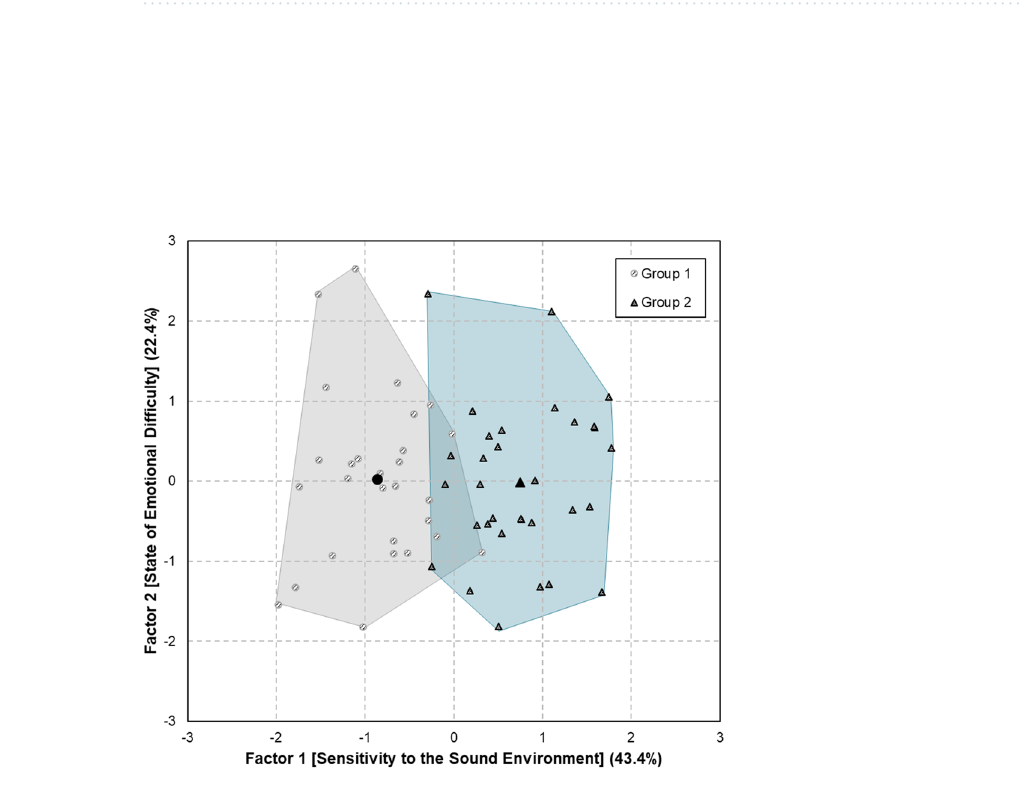
Table 2. Twenty-six index values for determining the optimal number of clusters.